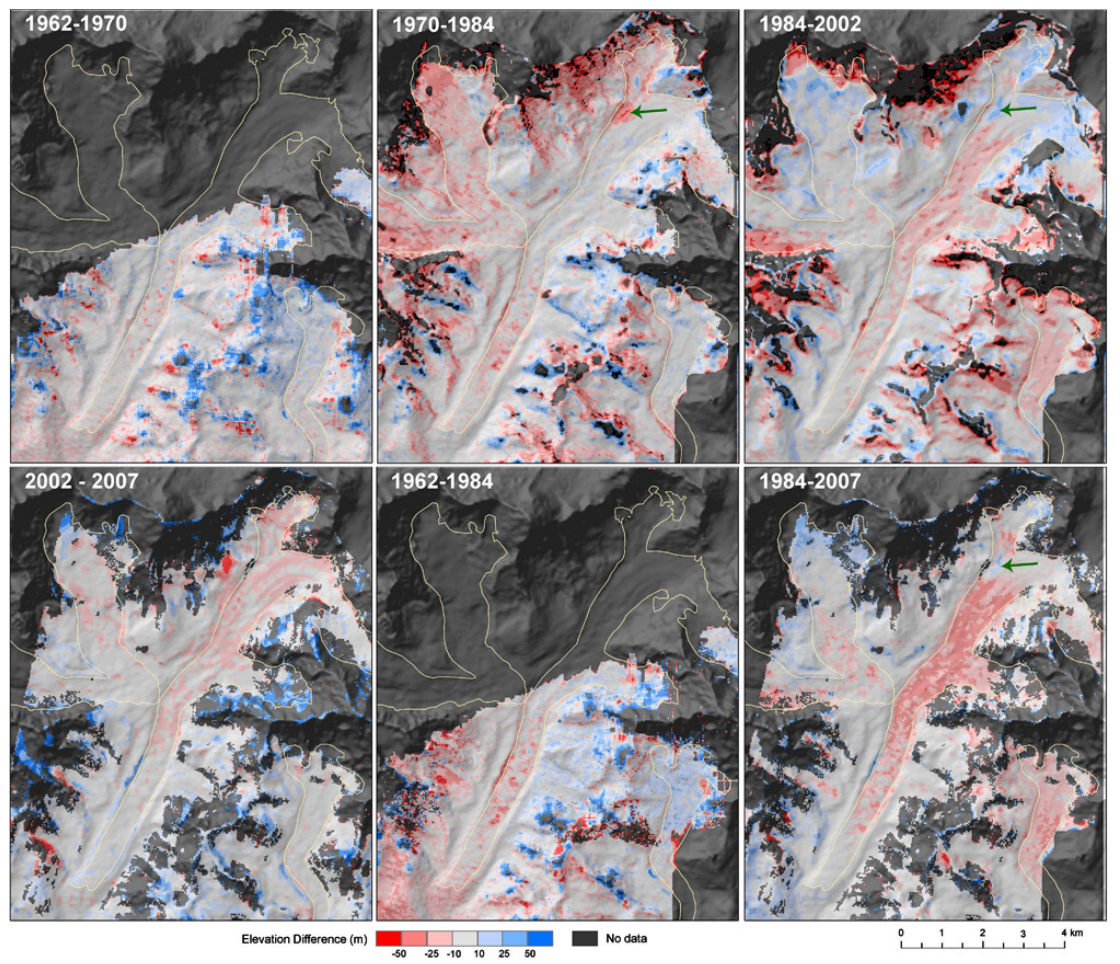
Fig. 4. DTM differences on Khumbu Glacier for different times.